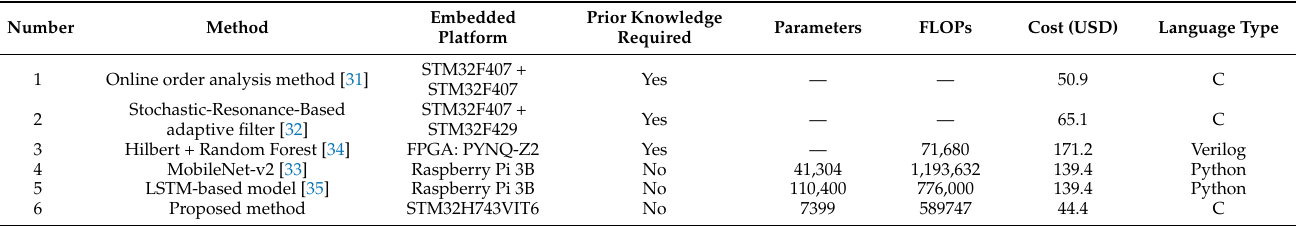
Table 9. Comparison of different methods.